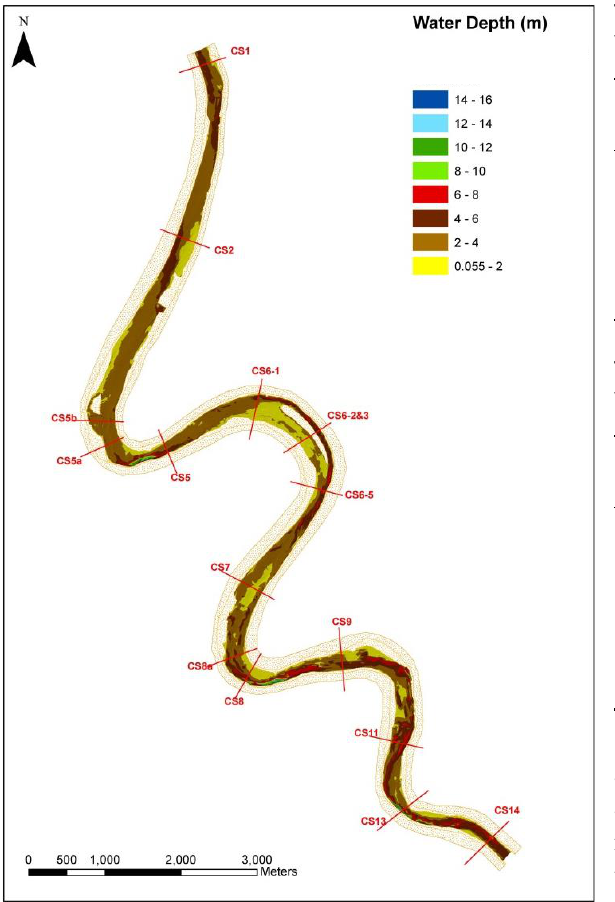
Figure 10. ( a ) Distribution of sand; ( b ) Distribution of silt; ( c ) Distribution of clay on the bed of Tigris River at Baghdad.